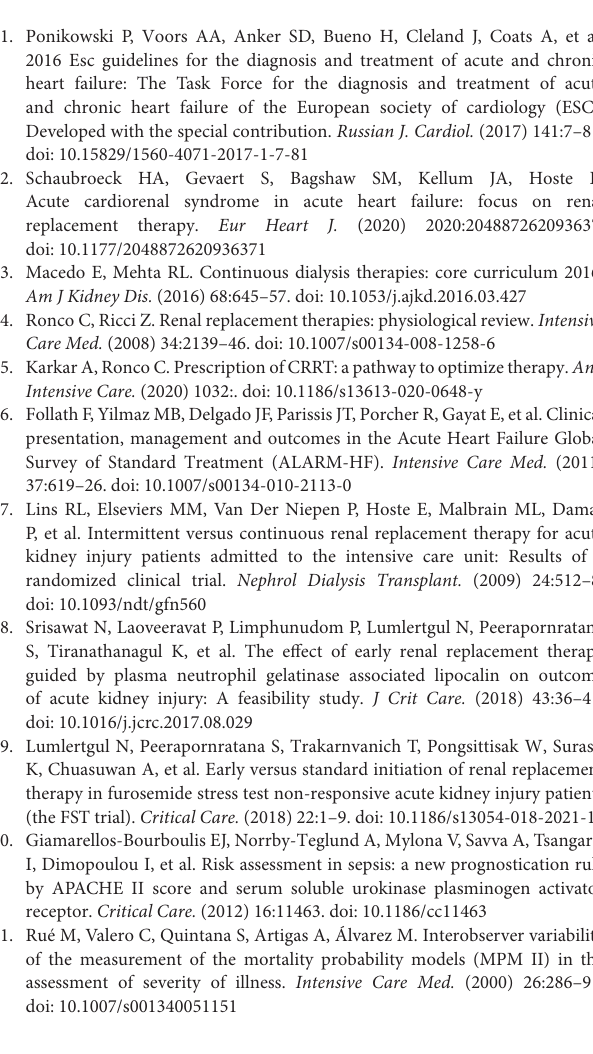
Supplementary Figure 1 | Development webserver of predicting nomogram model. Supplementary Table 1 | The baseline characteristics of the survivor cohort and the non-survivor cohort in the training cohort. Supplementary Table 2 | The demographics and clinical characteristics of the validation cohort and the training